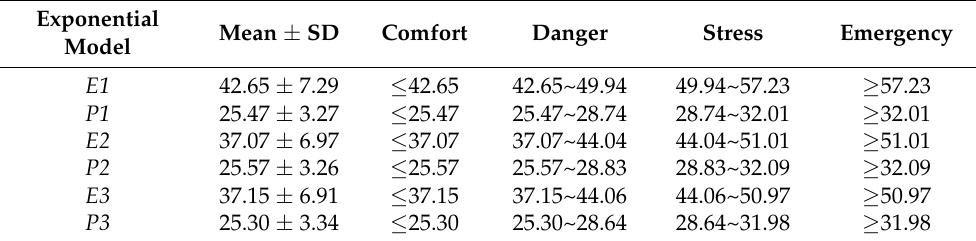
Table 5. Response scale of the developed comfort index of